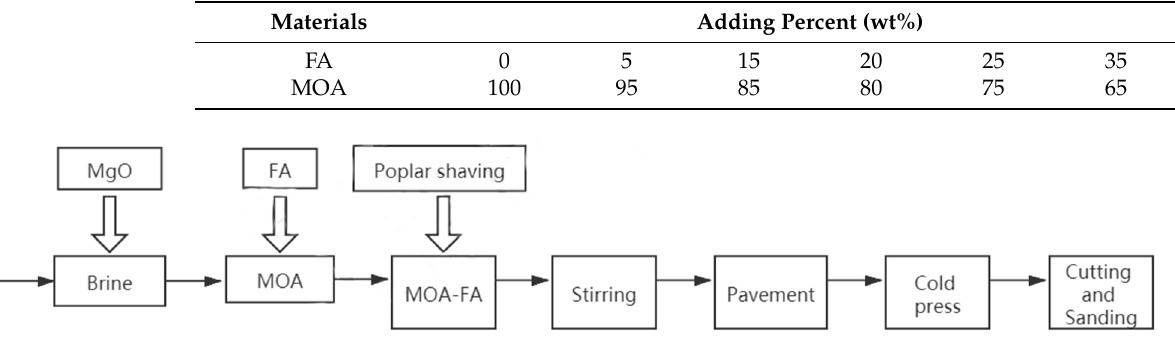
Figure 1. Production flow of